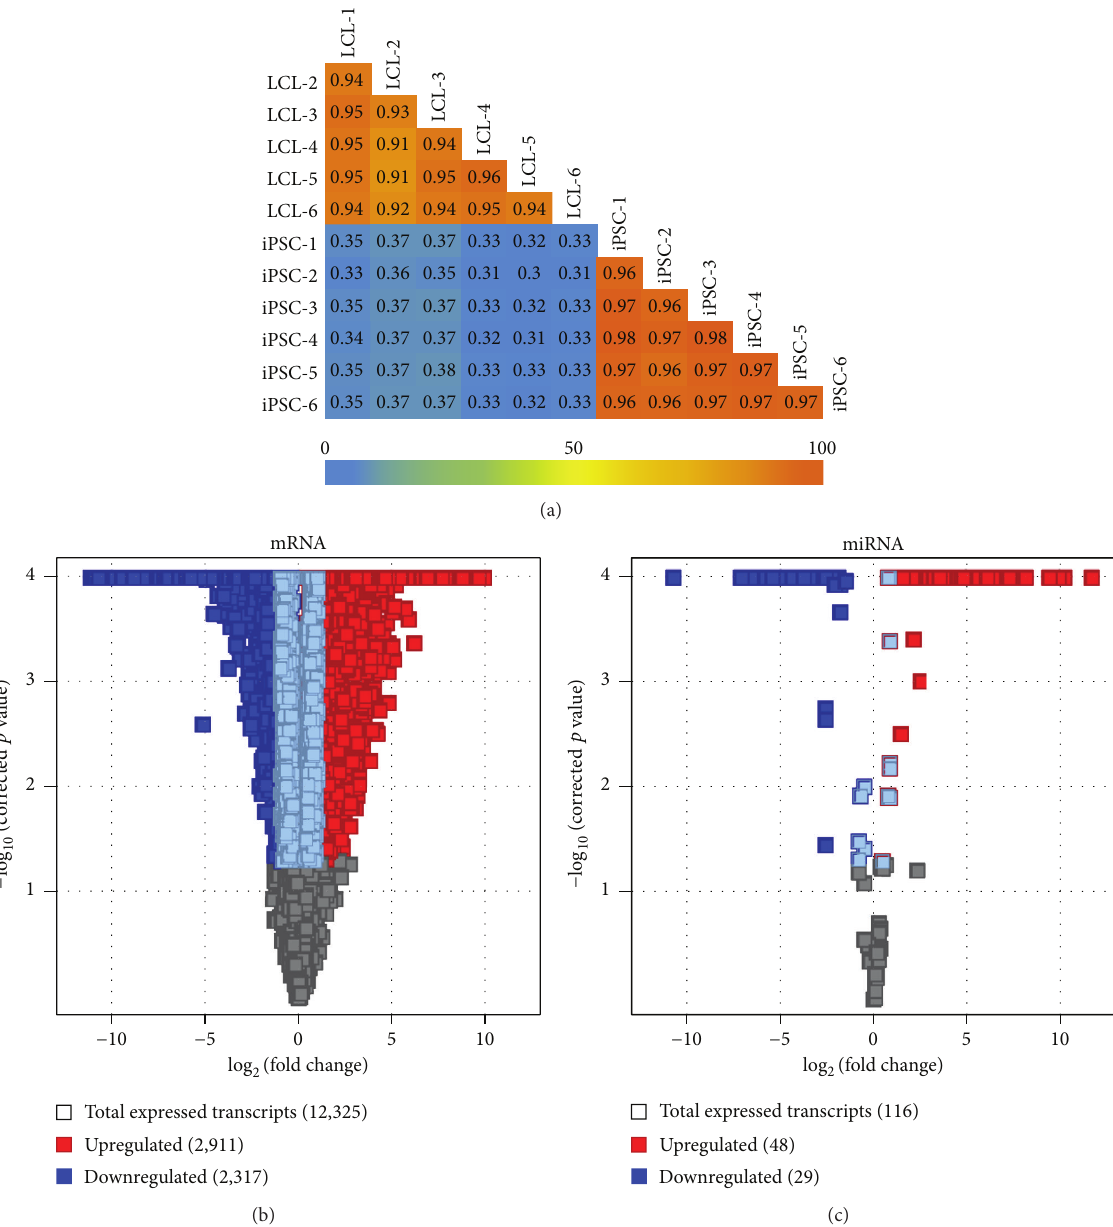
Figure 2: Differential gene expression statistics in LCL-to-iPSC reprogramming. (a) Expressed genes (NRC ≥ 20) correlation coefficient ( 𝑟 2 ) plots for LCLs versus iPSCs. (b) Volcano plots showing differentially expressed genes (mRNAs) between LCLs and their reprogrammed iPSCs. (c) Volcano plots showing differentially expressed miRNAs between LCLs and their reprogrammed